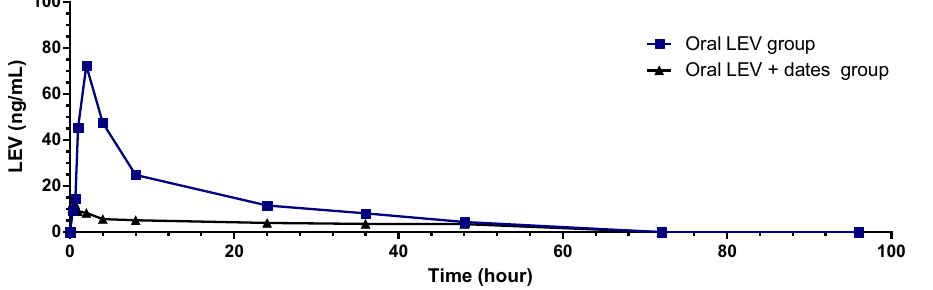
Figure 2. Pharmacokinetics profile of LEV administered orally or orally together with date molasses ( n =